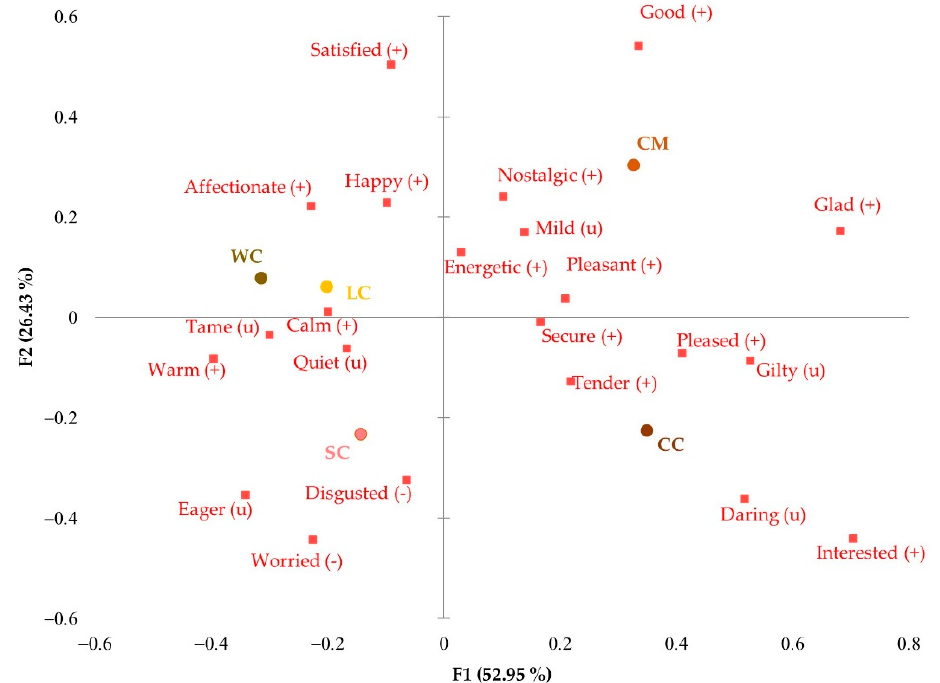
Figure 7. Principal component analysis of the significant emotional responses in class 1: WC, Walnut cake; LC, Leonor cake; SC, Saffron cake; CC, Coulant cake; CM, Chocomuffin.